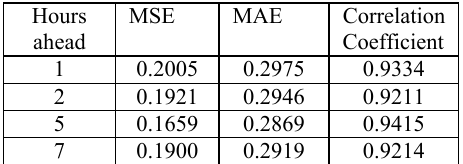
Table 4. Errors and correlation coefficients in Case 4 for all scenarios.